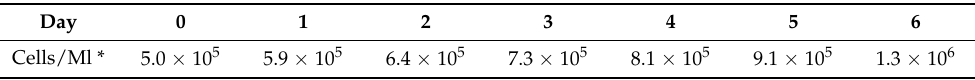
Table 1. Daily means of BmVIII-SCC cell counts over a 6-day culture period after seeding at 5.0 × 10 5 cells/mL on day 0.